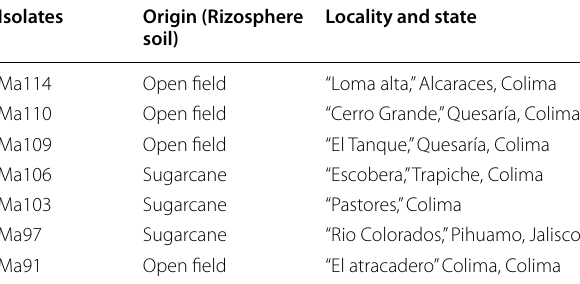
Table 1 Source and origin of the Metarhizium isolates Isolates Origin (Rizosphere